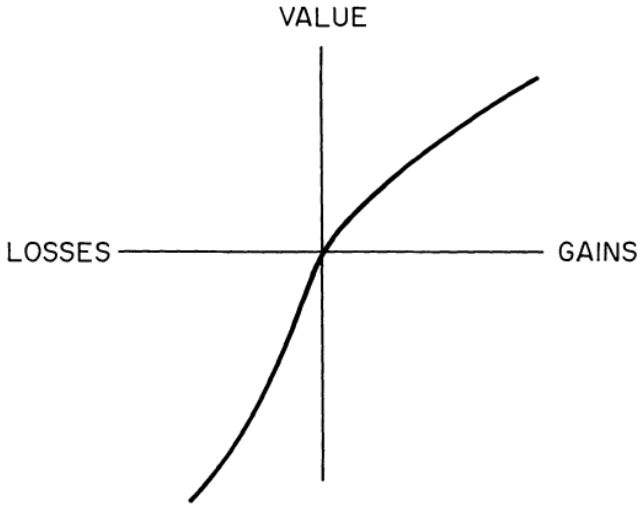
Figure 2. A hypothetical weighting function. Source: Tversky and Kahneman (1991).